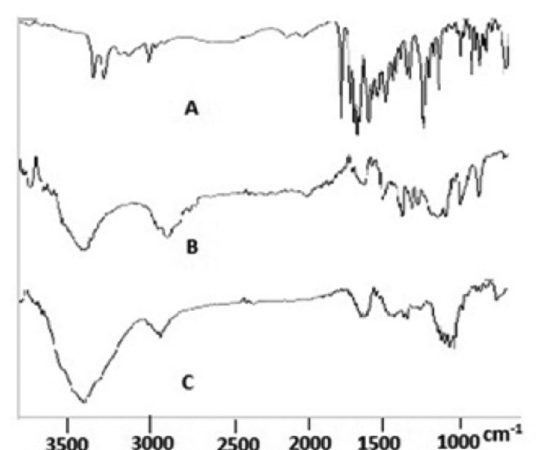
FIGURE 5 - FTIR spectra of (A) Pure drug (B) PEO 1105 powder (C) CCT with PEO WSR